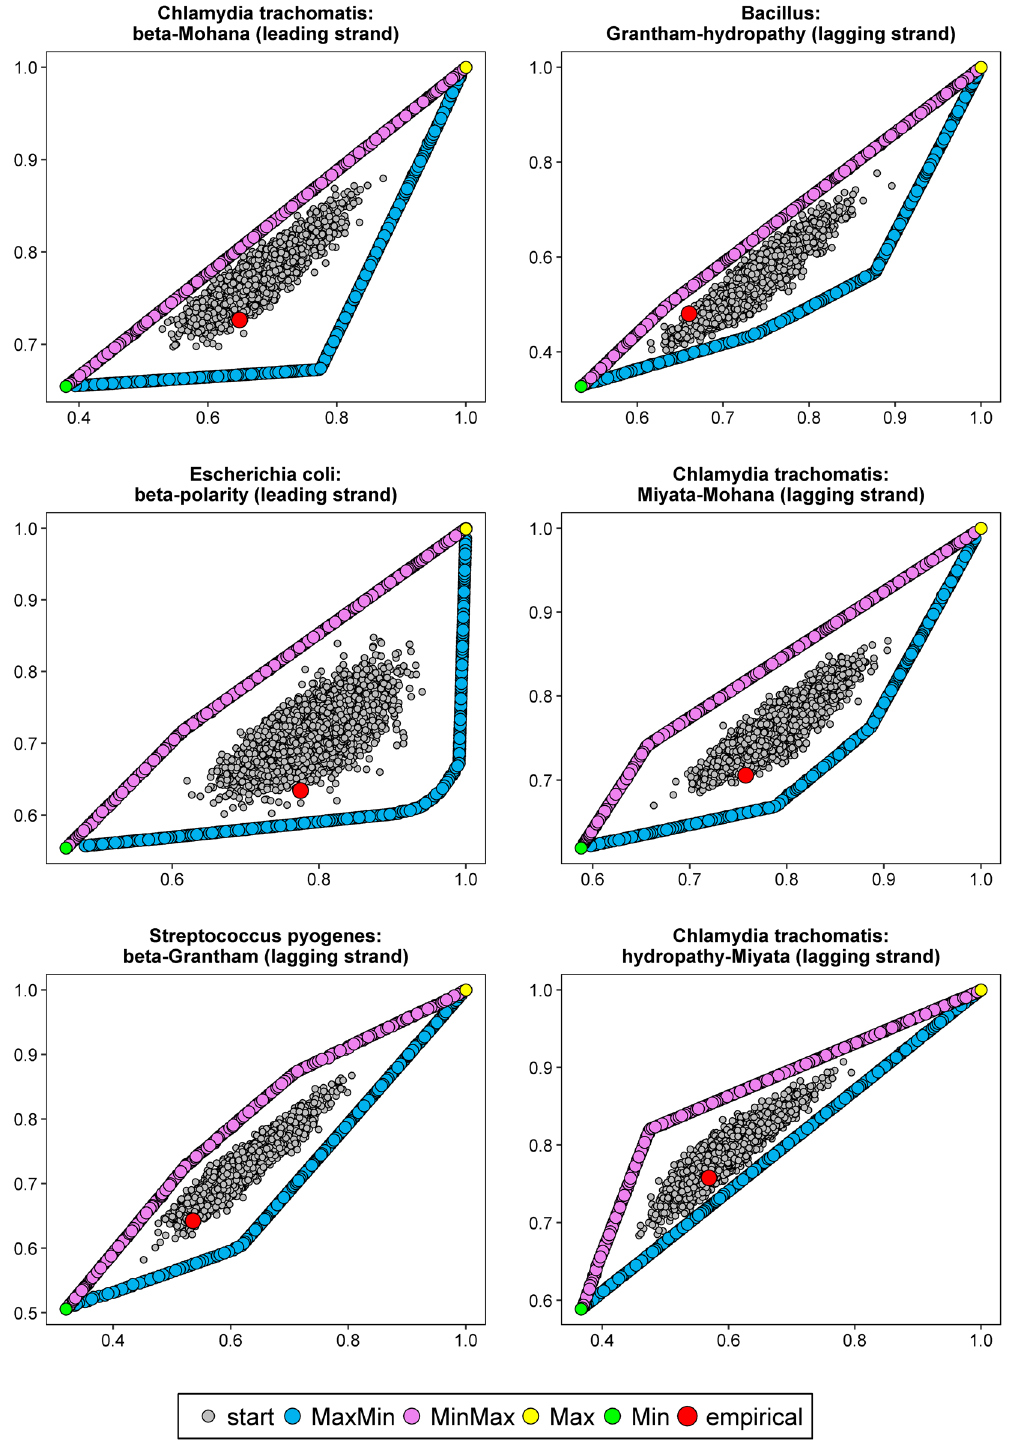
Figure 4. Comparison of costs of amino acid replacements in two selected physicochemical properties, generated by: random started matrices (start), empirical matrices (empirical), matrices maximizing one and minimizing other property (MaxMin) and vice versa (MinMax) as well as matrices maximizing (Max) or minimizing (Min) the both